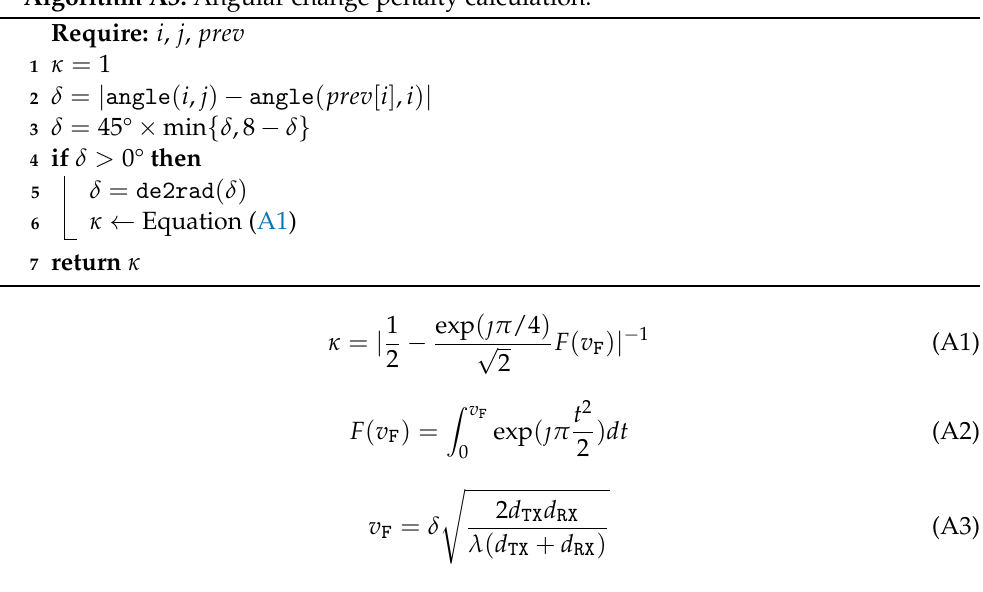
Algorithm A3: Angular change penalty